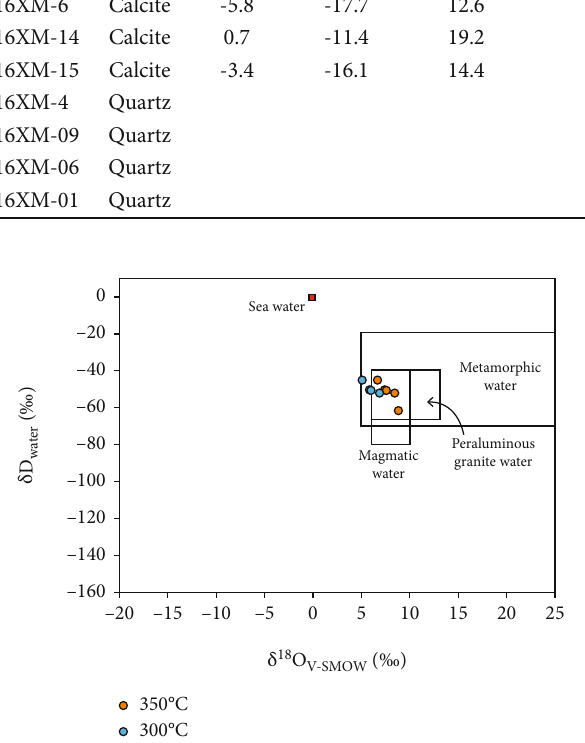
Figure 8: Calculated oxygen and hydrogen isotope compositions of fl uids in equilibrium with quartz from the Xinmin deposit. The fi elds for metamorphic fl uids are after [33], magmatic and peraluminous granite fi elds from [34, 35].